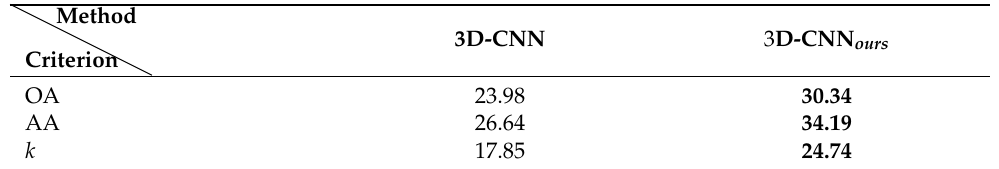
Table 12. Classification accuracy (%) with five training samples of the Salinas dataset after using PCA to reserve 100 important bands.